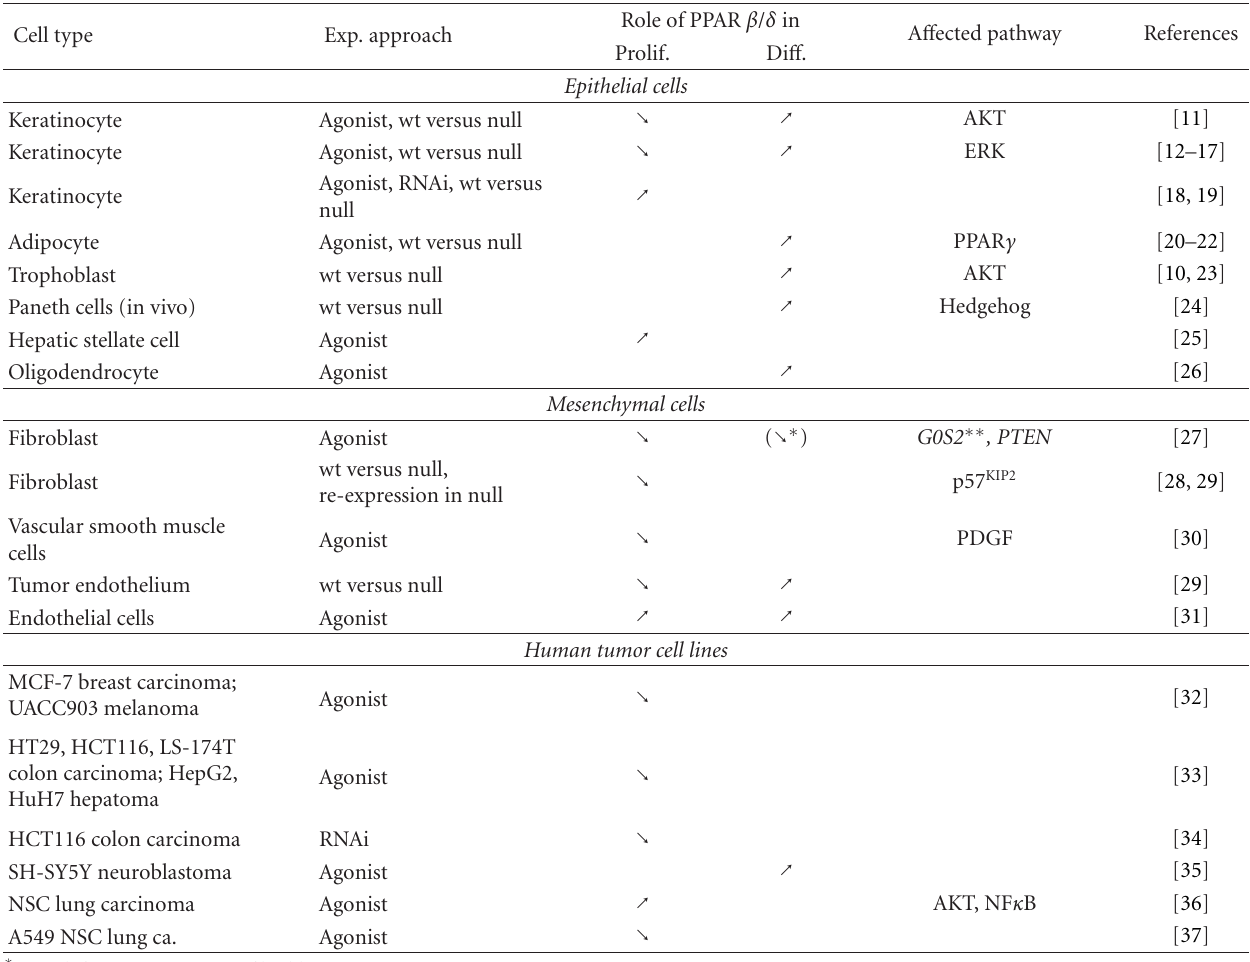
Table 1: E ff ects of PPAR β / δ on cell proliferation and di ff